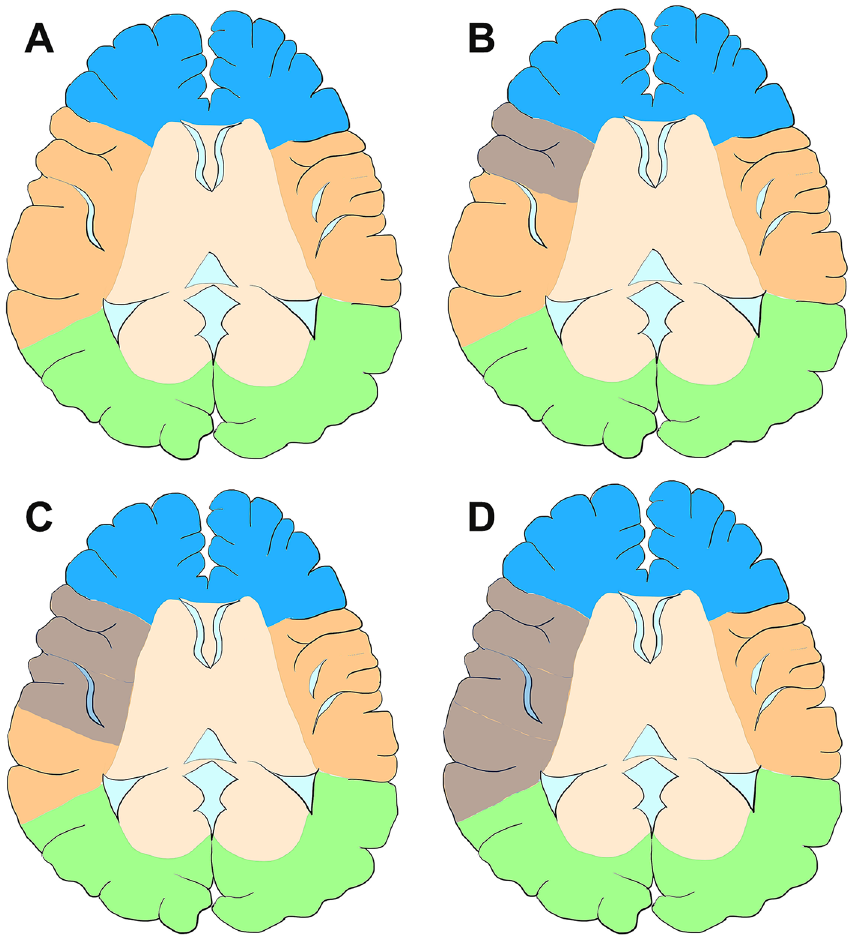
Figure 1. Schematic diagrams of CIES. ( A ) Diagrams showed no infarction preoperatively. CIES = 0 point, ( B ) diagrams indicated infarction (gray area) on the right temporal lobe, affecting about 1/3 of the lobe. CIES = 1. ( C ) Diagrams indicated infarction (gray area) on the right temporal lobe, affecting about 2/3 of the lobe, CIES = 2. ( D ) Diagrams indicated infarction (gray area) on the right temporal lobe, affecting about whole lobe. CIES =